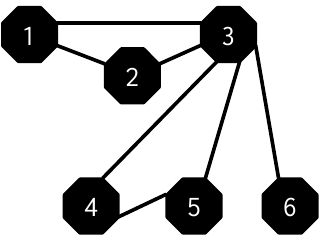
Figure 5. Similarity link between product types.